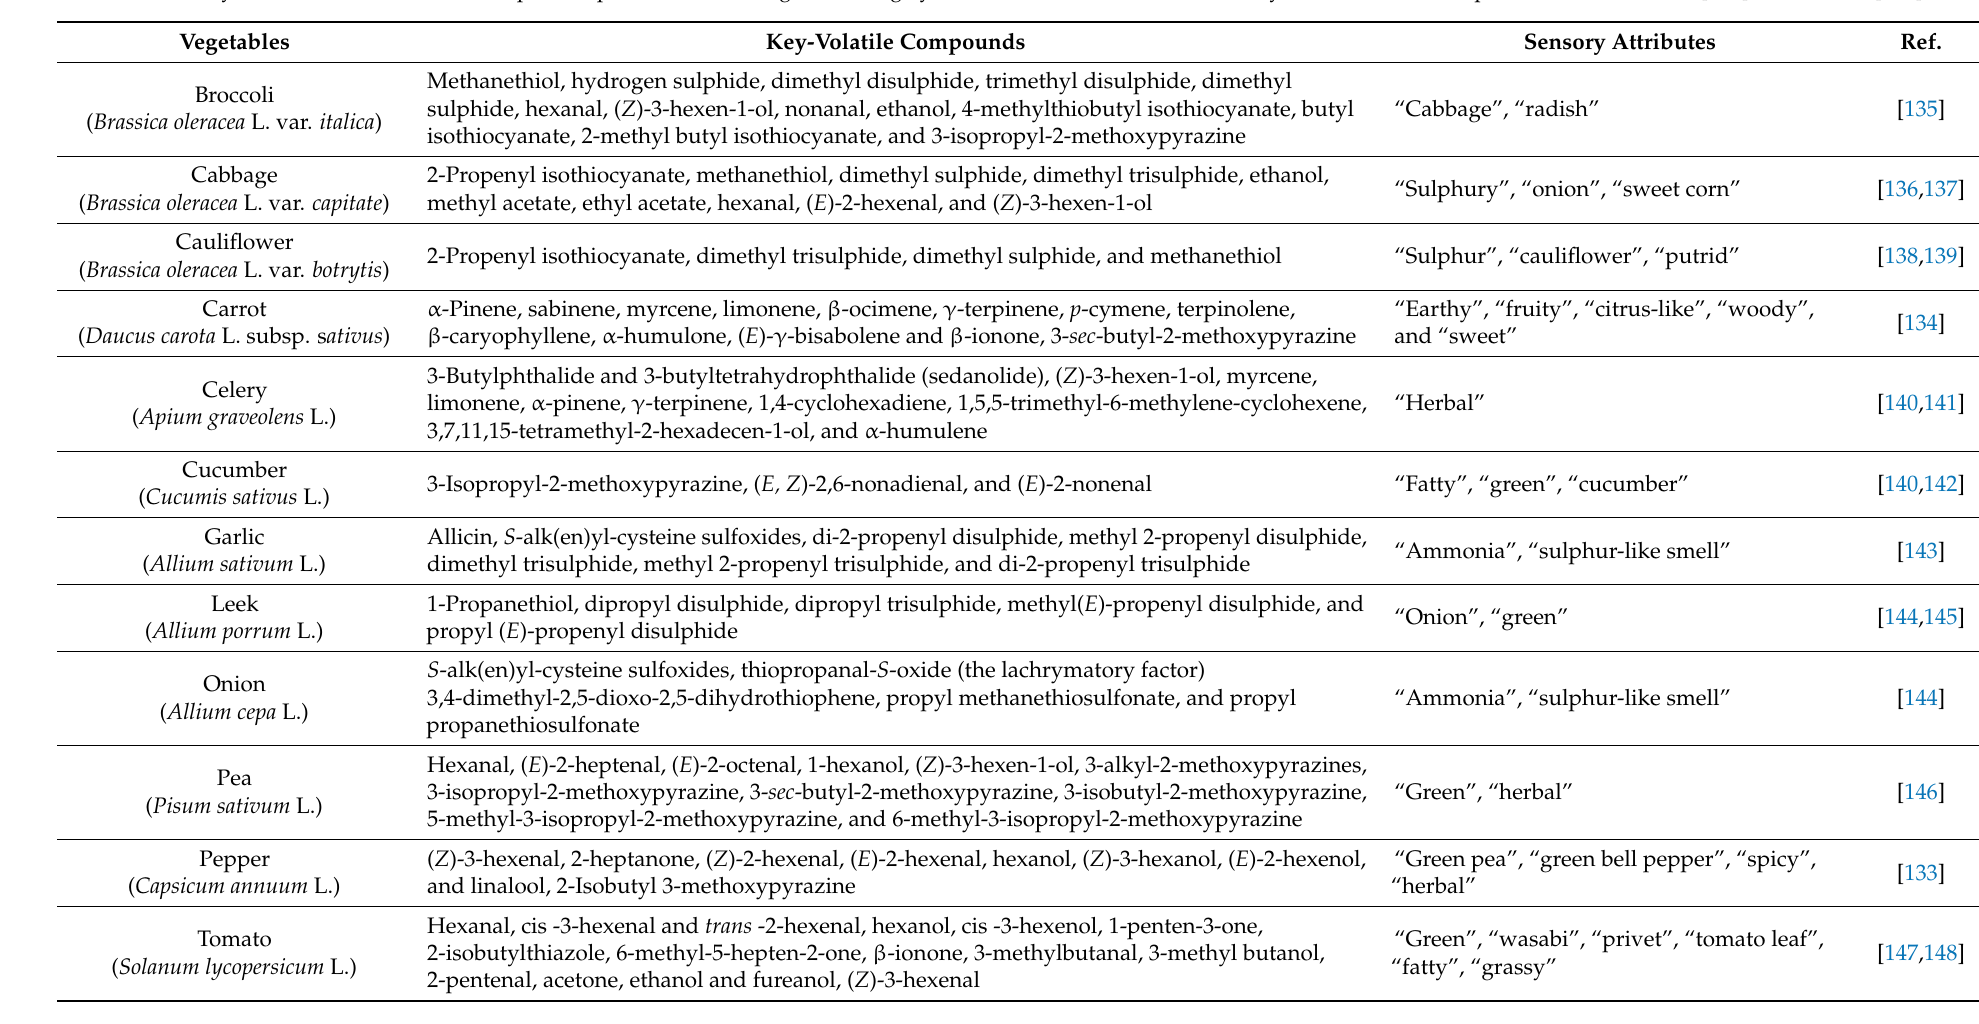
Table 4. Key volatile and nonvolatile compounds present in some vegetables largely consumed worldwide. The sensory attributes were adapted from Parker et al. [126] and Maarse [134]. Vegetables Key-Volatile